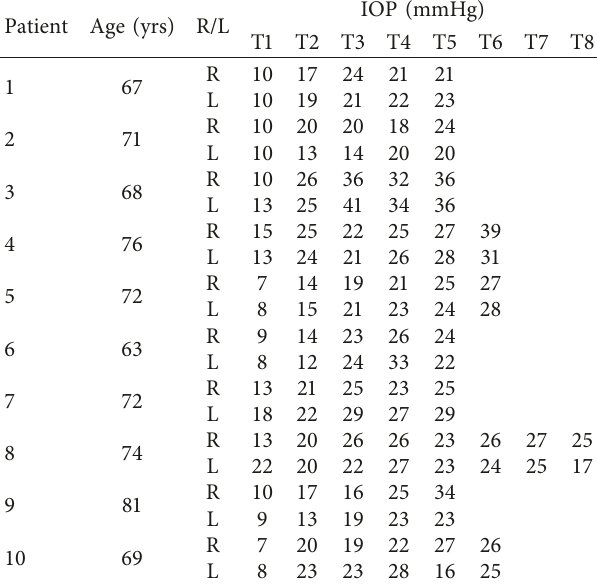
Table 3: Retinal nerve fiber layer thickness and visual field at each measure point.